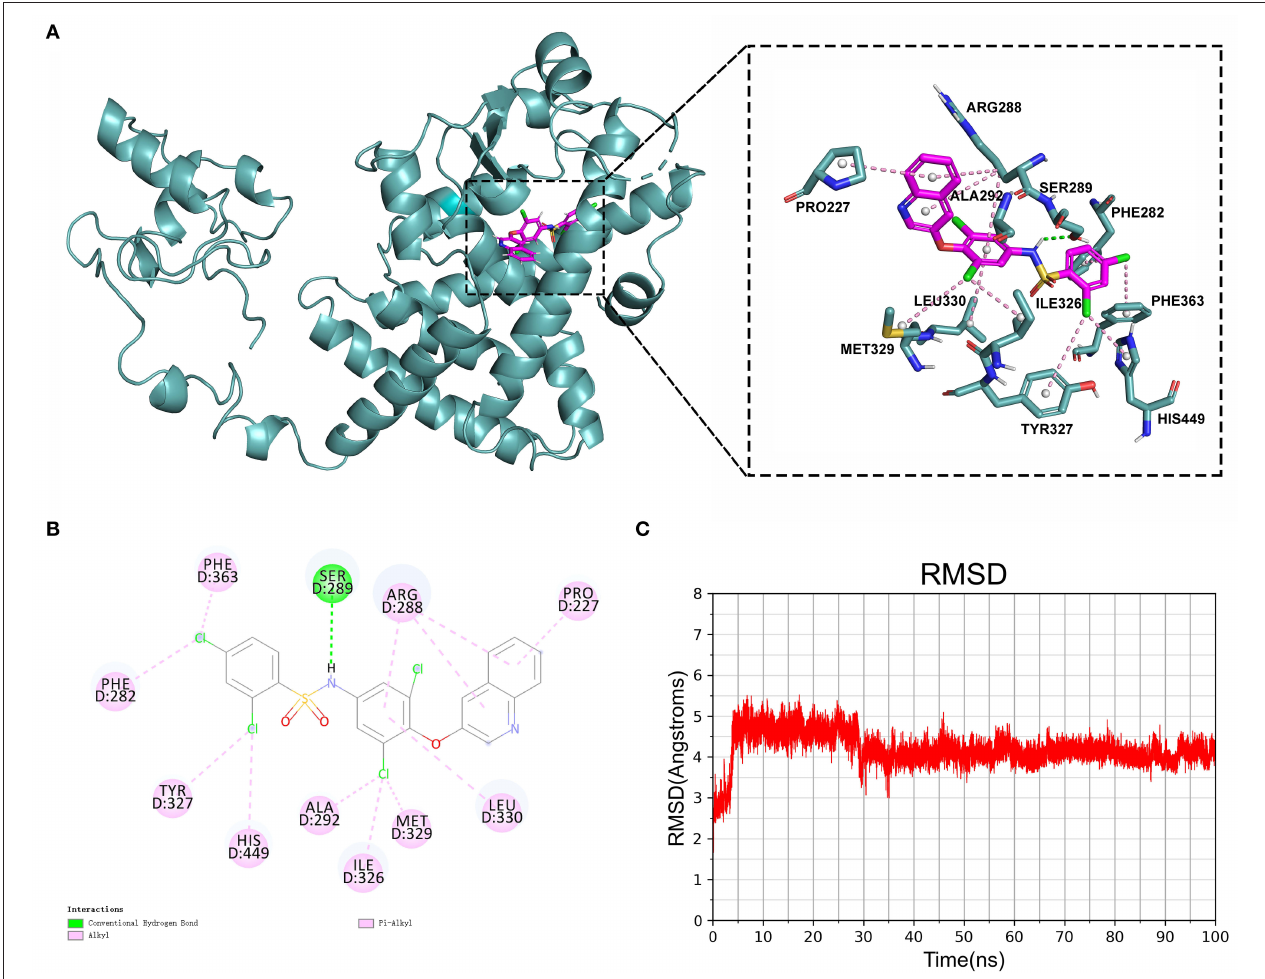
FIGURE 8 | Analysis of molecular docking. (A) Binding pattern of PPARG protein and compound DB05490. (B) A two-dimensional (2D) interaction map of PPARG protein and compound DB05490. (C) Root mean square deviation (RMSD) values for compound DB05490 during a 100 ns molecular dynamics